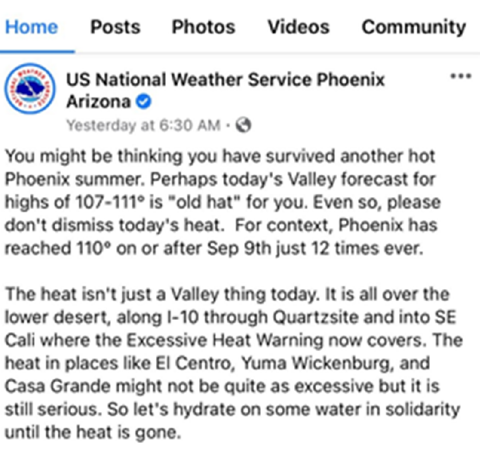
Figure A1. Example of NWS Phoenix heat risk messaging in- formed by the commonplaces identified (9 September